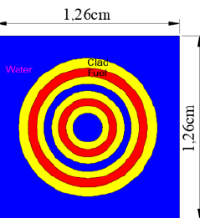
Figure 4. The geometry of the multi-fuel pin cell problem